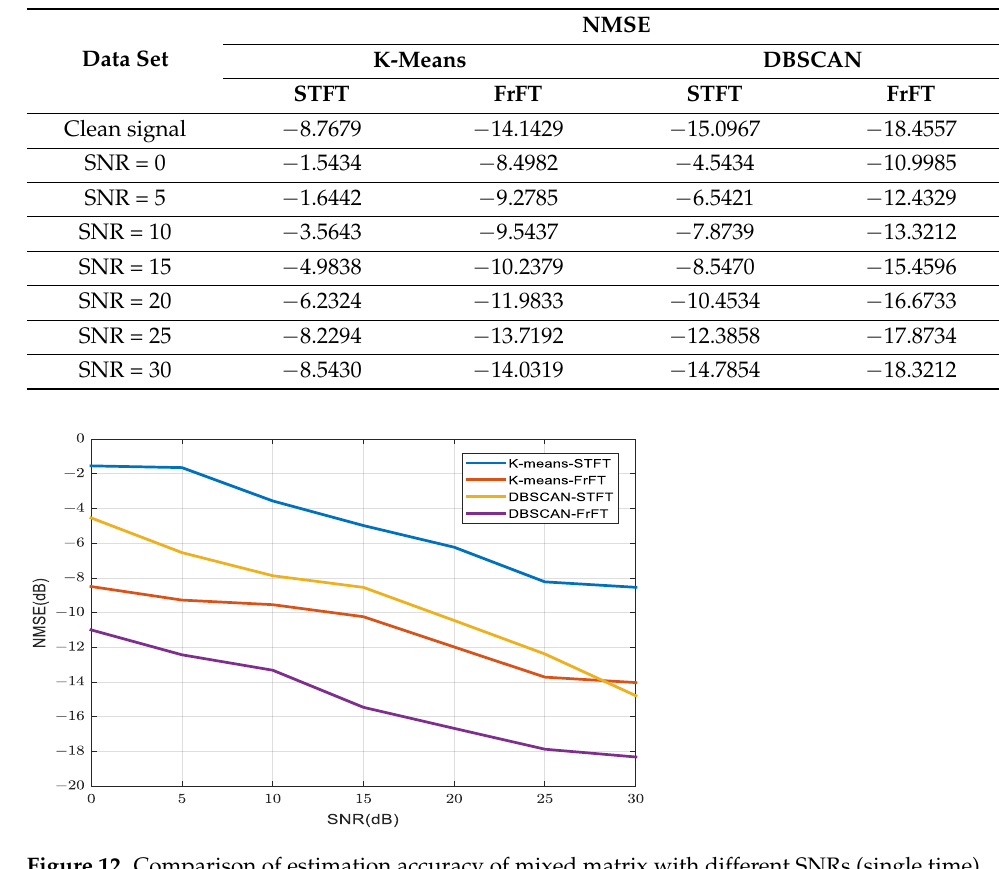
Table 3. Comparison of estimation accuracy of mixed matrix obtained by different clustering algorithms.